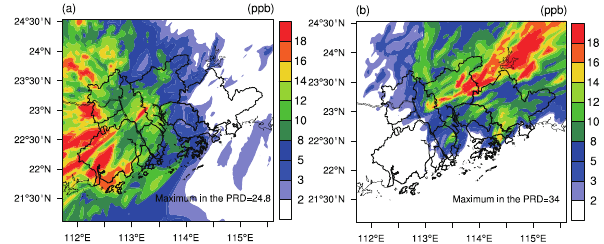
Fig. 7. Maximum hourly impacts of BVOC emissions on the surface ozone peak (a) in autumn and (b) in